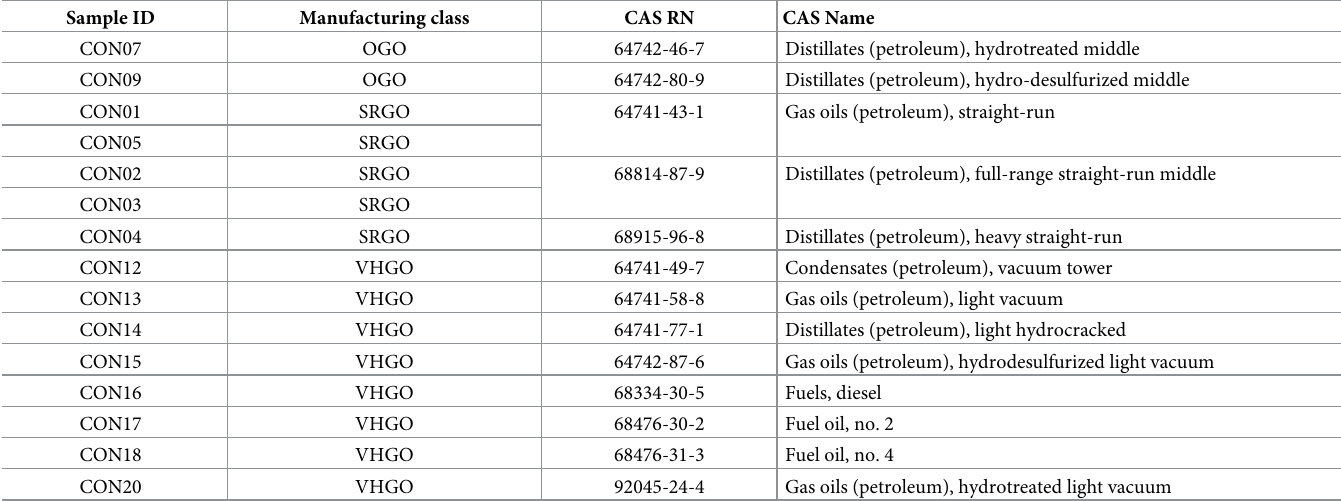
Table 2. Petroleum UVCB samples.